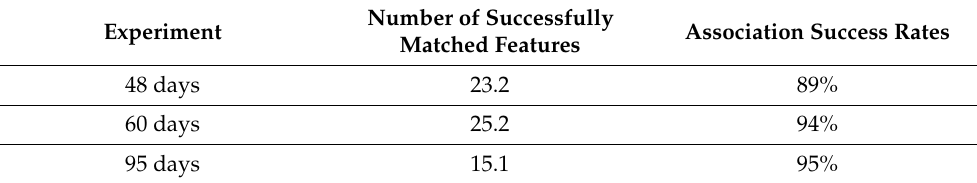
Table 5. The number of features matched successfully per sweep for different growth days.